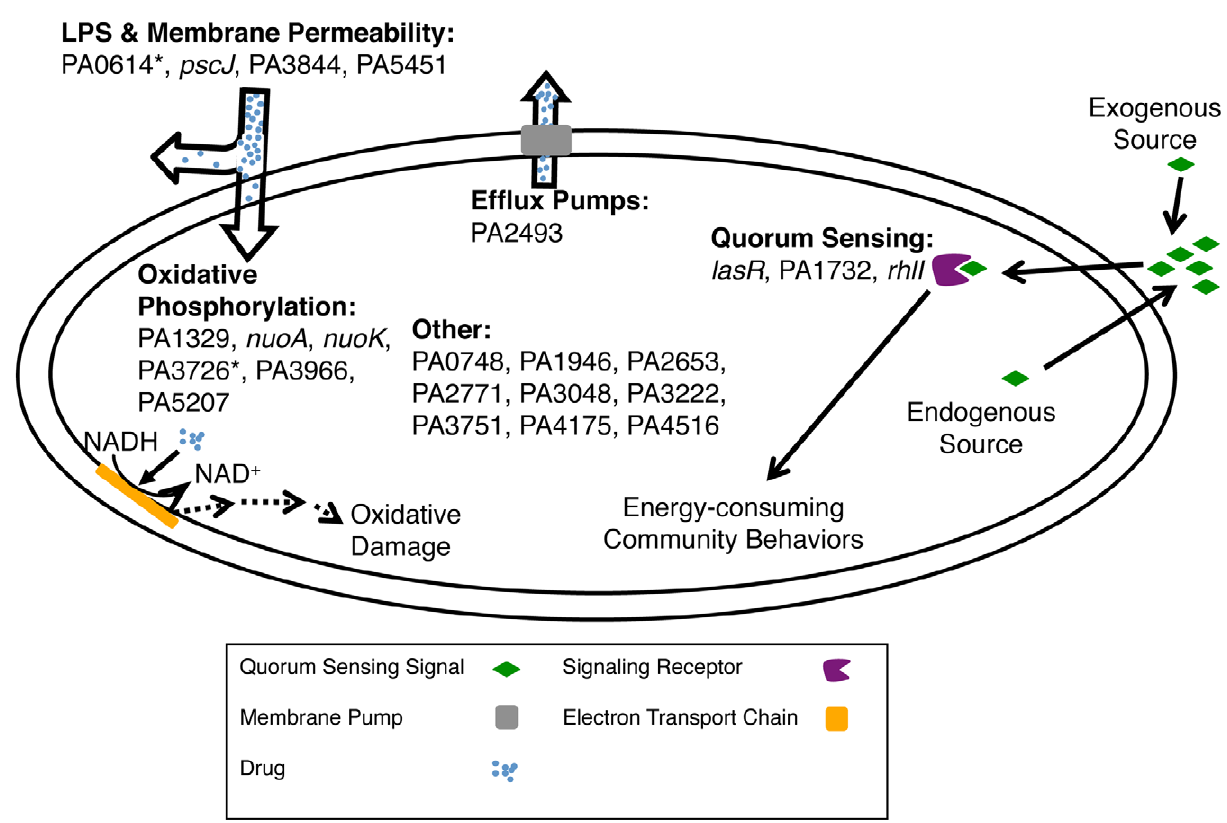
Figure 6. Mechanisms for altering biofilm-mediated antibiotic tolerance. Shown are pathways that the genes from Figure 3A and 3B likely use to modulate biofilm-mediated antibiotic tolerance in P. aeruginosa . The ‘‘*’’ indicates that the altered antibiotic-susceptibility is specific to the biofilm state. Genes in the ‘Other’ category likely affect uncharacterized pathways or pathways not assayed in this work.